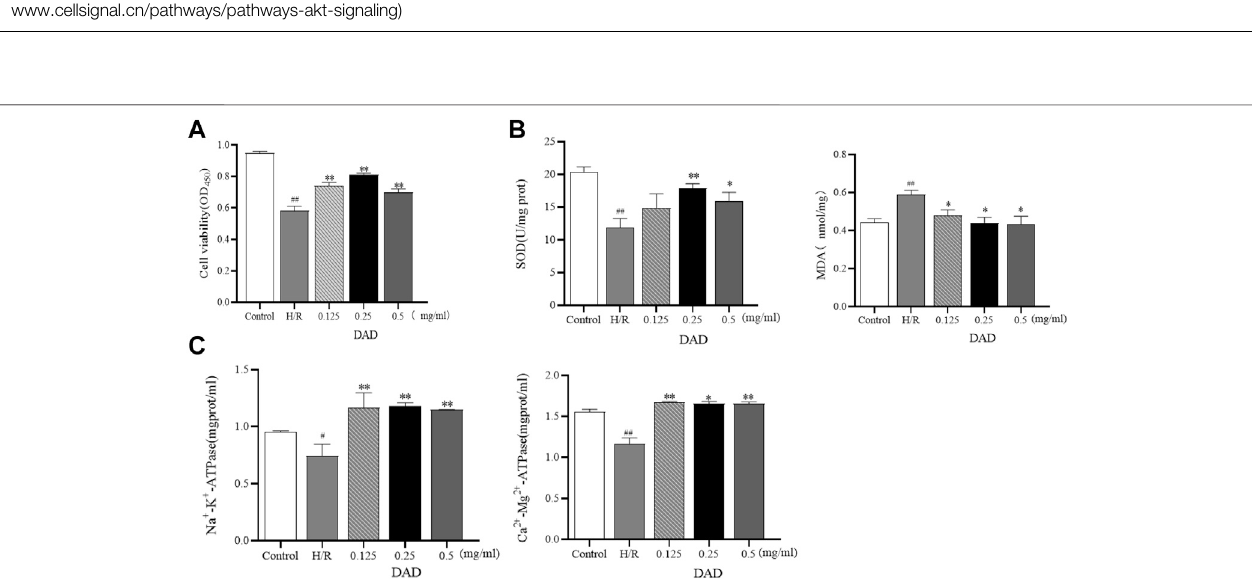
FIGURE 3 | Effects of dried ginger-aconite decoction (DAD) on survival rate and biochemical parameters of H9C2 cells damaged by H/R. (A) Effect on the survival rate of H9C2 cells. (B) Effect on oxidative stress factors MDA, SOD. (C) The effect on the activity of ATPase. Data were presented as mean standard deviation (SD). #p < 0.05, ##p < 0.01 vs. control group. *p < 0.05, **p < 0.01 vs. H/R group.